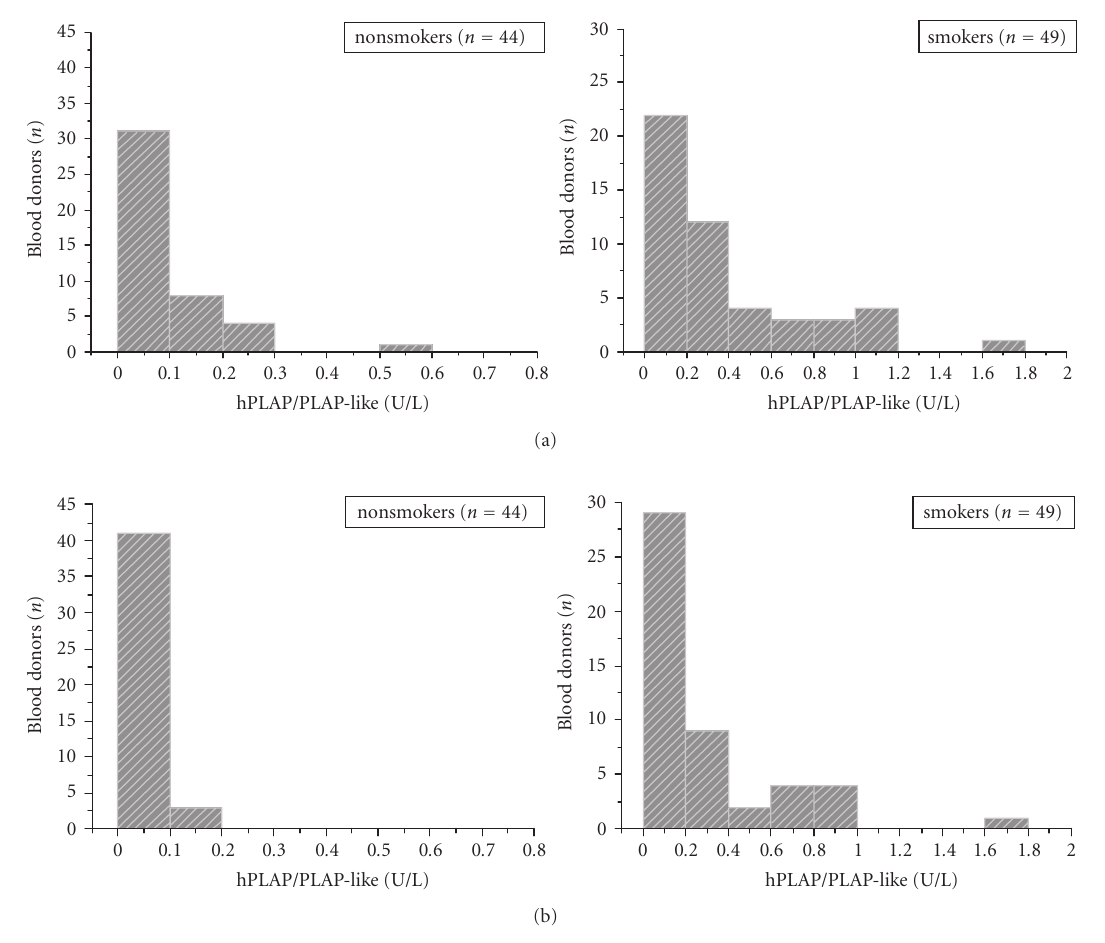
Figure 2: Distribution of hPLAP/PLAP-like activity in serum of blood donors grouped according to smoking habits ( n = 93) for (a) ICA- PLAP and (b) ICA-PEP assays.